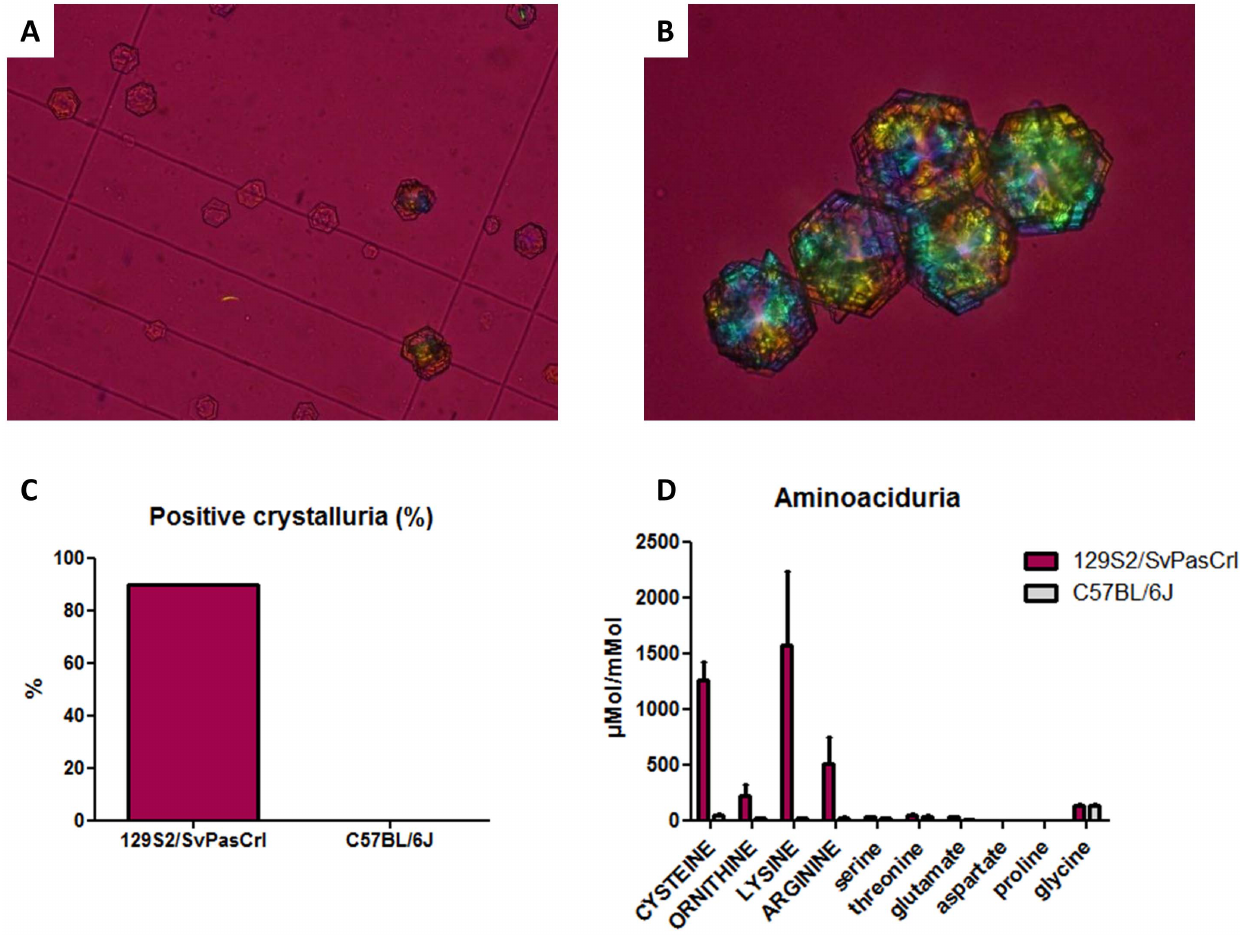
Figure 2. 129S2/SvPasCrl crystalluria and aminoaciduria are similar to those of human patients with cystinuria. A–B , Typical flat hexagonal cystine crystals were present in 129S2/SvPasCrl fresh urine. C , Ninety percent of 129S2/SvPasCrl mice presented crystalluria (p=0.0001 vs C57BL/6J mice). D , Urinary aminoacid chromatography has been performed in 129S2/SvPasCrl mice (n=5) and C57BL/6J mice (n=3). Dibasic aminoacids including cysteine (reduced form of cystine) were significantly higher in 129S2/SvPasCrl mice urine (p=0.036 for each dibasic aminoacid) whereas other aminoacid renal excretion was similar in both strains. Some representative aminoacids are depicted in Figure 1D. Results are expressed as aminoacid concentration ( m Mol)/creatinine concentration (mMol) in